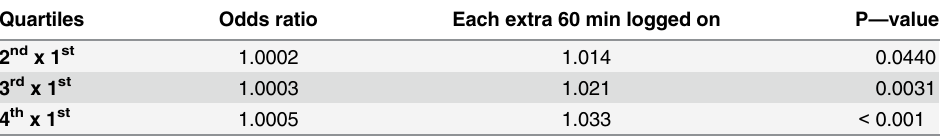
Number of minutes logged on during the rotation period and the probability of being in better grades